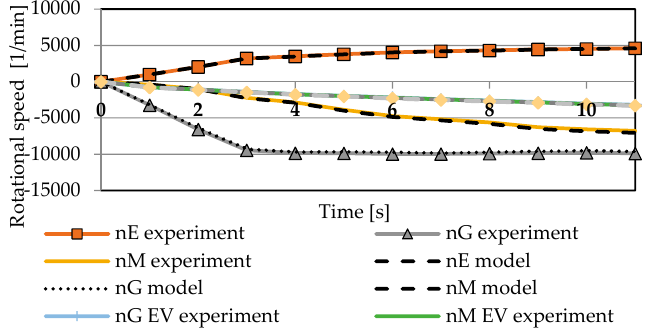
Figure 6. Rotational speed of the internal combustion engine, the electric motor and the generator versus time.